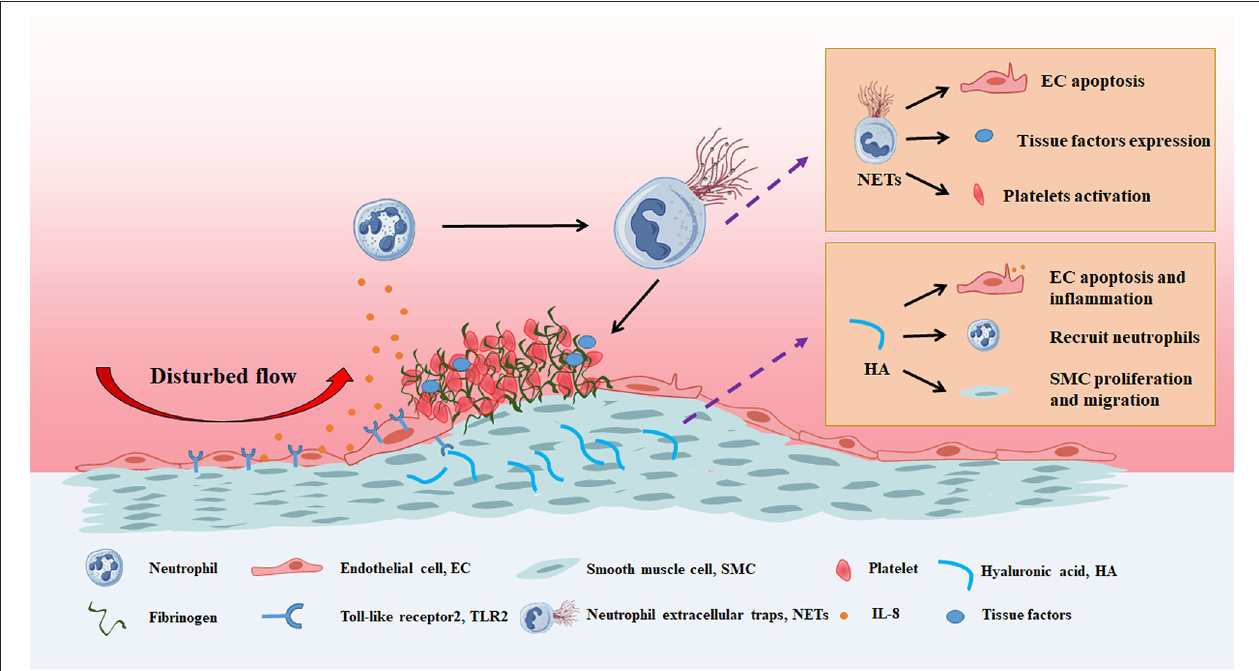
FIGURE 2 | Possible mechanisms between disturbed flow, neutrophil extracellular traps and hyaluronic acid in eroded plaque. The disturbed flow triggers the TLR2 dependent endothelial cell apoptosis and secretion of IL-8, leading to neutrophil recruitment, activation and release of neutrophil extracellular traps, aggravate the injury of endothelial cell layer and enhances the thrombus formation. In addition, accumulated hyaluronic acid induces apoptosis and inflammation in endothelial cells, followed by neutrophils adhesion. Hyaluronic acid also promotes the proliferation and migration of smooth muscle cells.